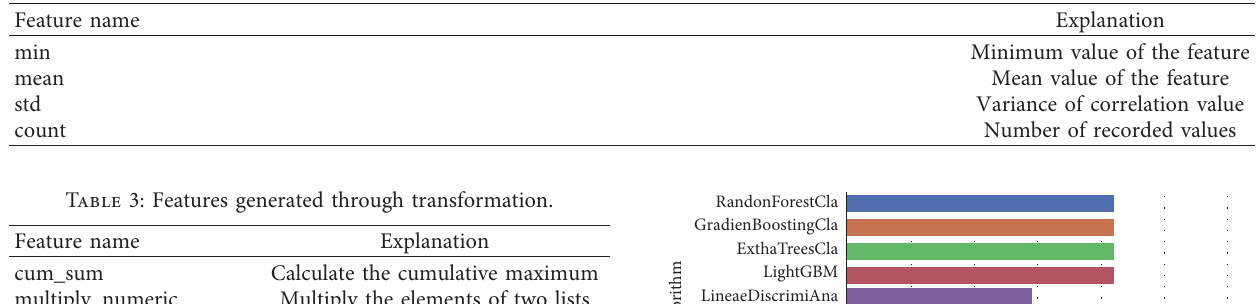
Table 2: Features generated through aggregation.